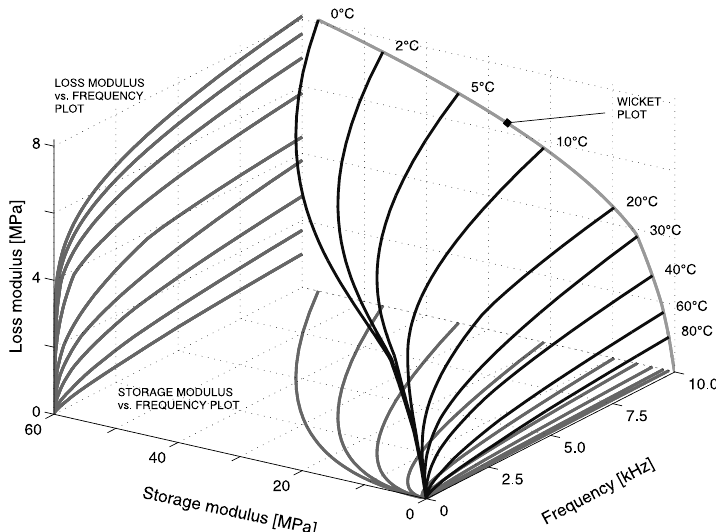
Fig. 1. Three-dimensional representation of the complex modulus.